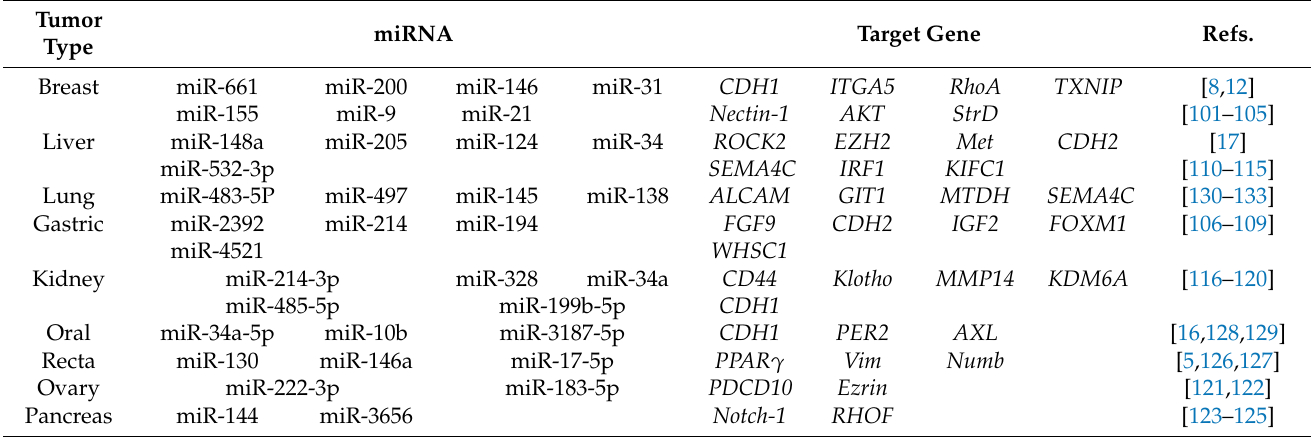
Table 2. Distinct miRNAs Targeting Non-Transcription Factors to Regulate Cancer